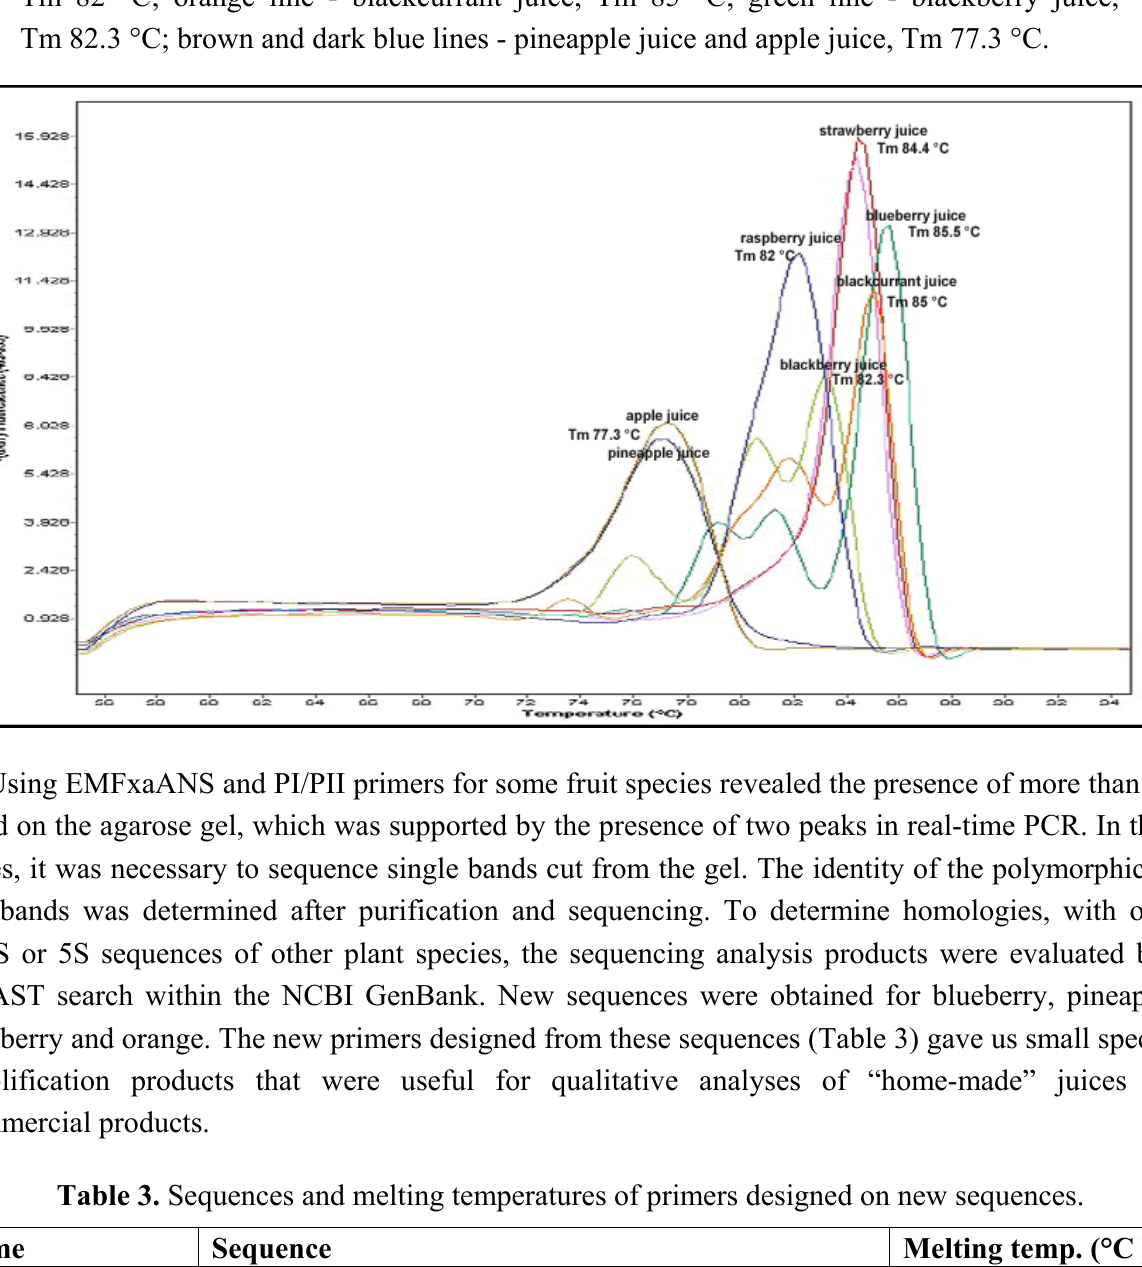
Figure 3. Melting peaks resulting from amplification with EMFxaANS primers showing the different melting temperatures for different fruit juices: pink line - strawberry juice, Tm 84.4 °C; light blue line - blueberry juice, Tm 85.5 °C; blue line - raspberry juice, Tm 82 °C; orange line - blackcurrant juice, Tm 85 °C; green line - blackberry juice,